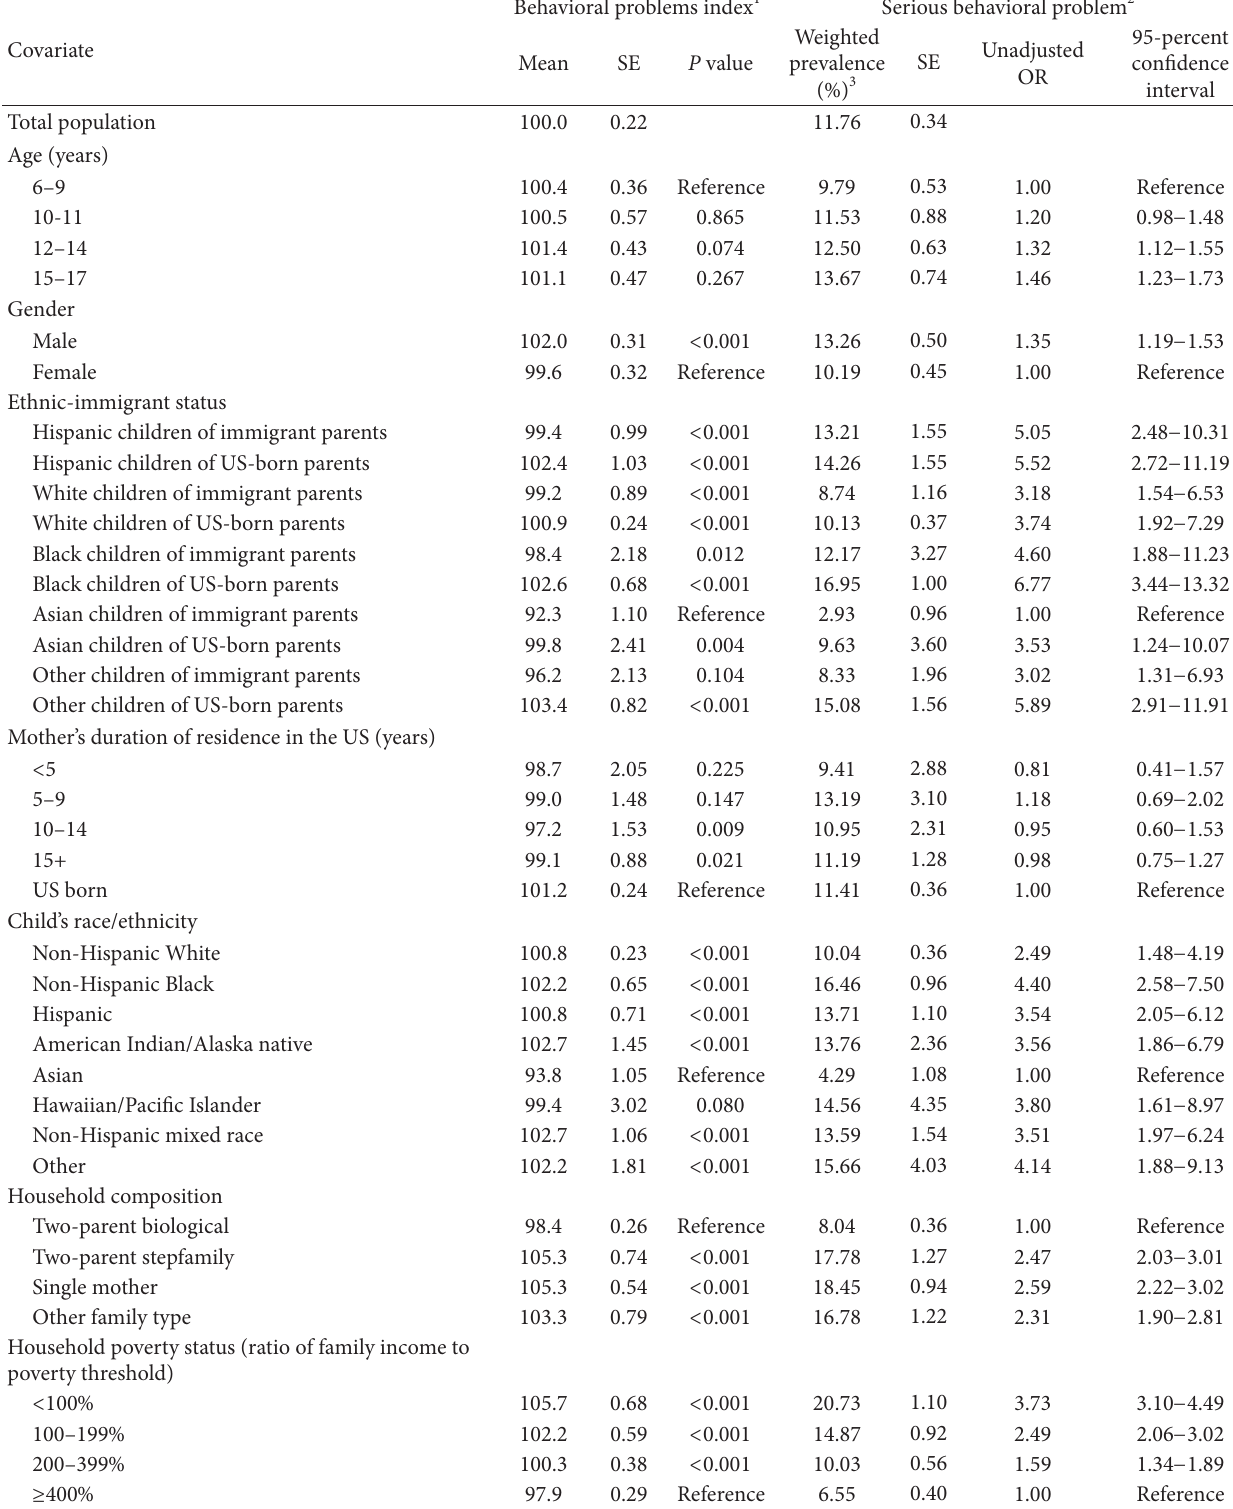
T 4: Mean behavioral problems index values and prevalence and unadjusted odds of serious behavioral problems according to ethnic- immigrant status and sociodemographic and behavioral characteristics, US children aged 6–17 years: the 2007 National Survey of Children’s Health ( N =